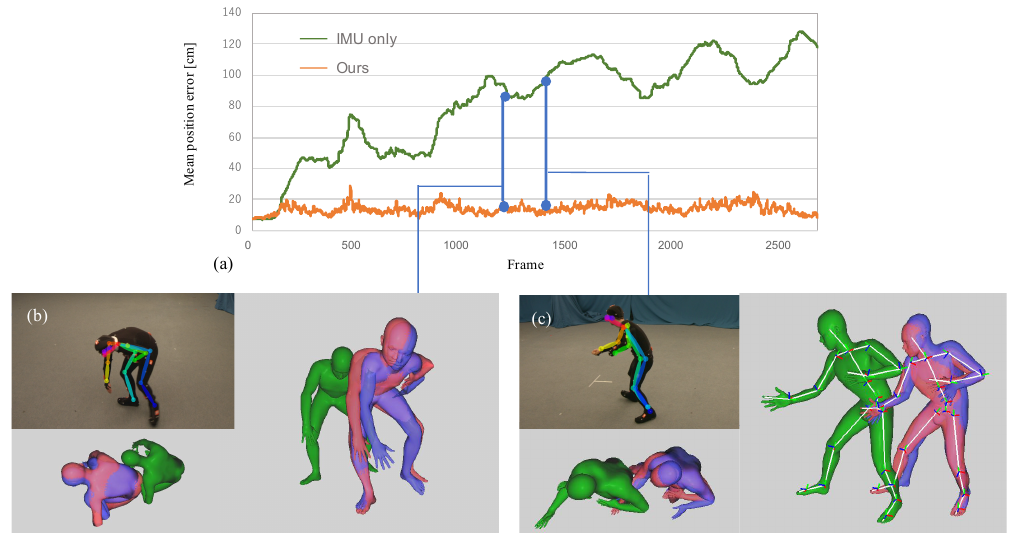
Figure 3. The top graph ( a ) represents per joint mean position error for each frame. The bottom figures ( b ) and ( c ) illustrate the the view of the used single camera and the detected joints by the 2D joint detector, OpenPose [6]. The human models colored in green, red, and blue represent the inference by IMU only, the proposed approach, and ground-truth from optical MoCap, respectively. It is observed that the position of the foot touching the ground is estimated